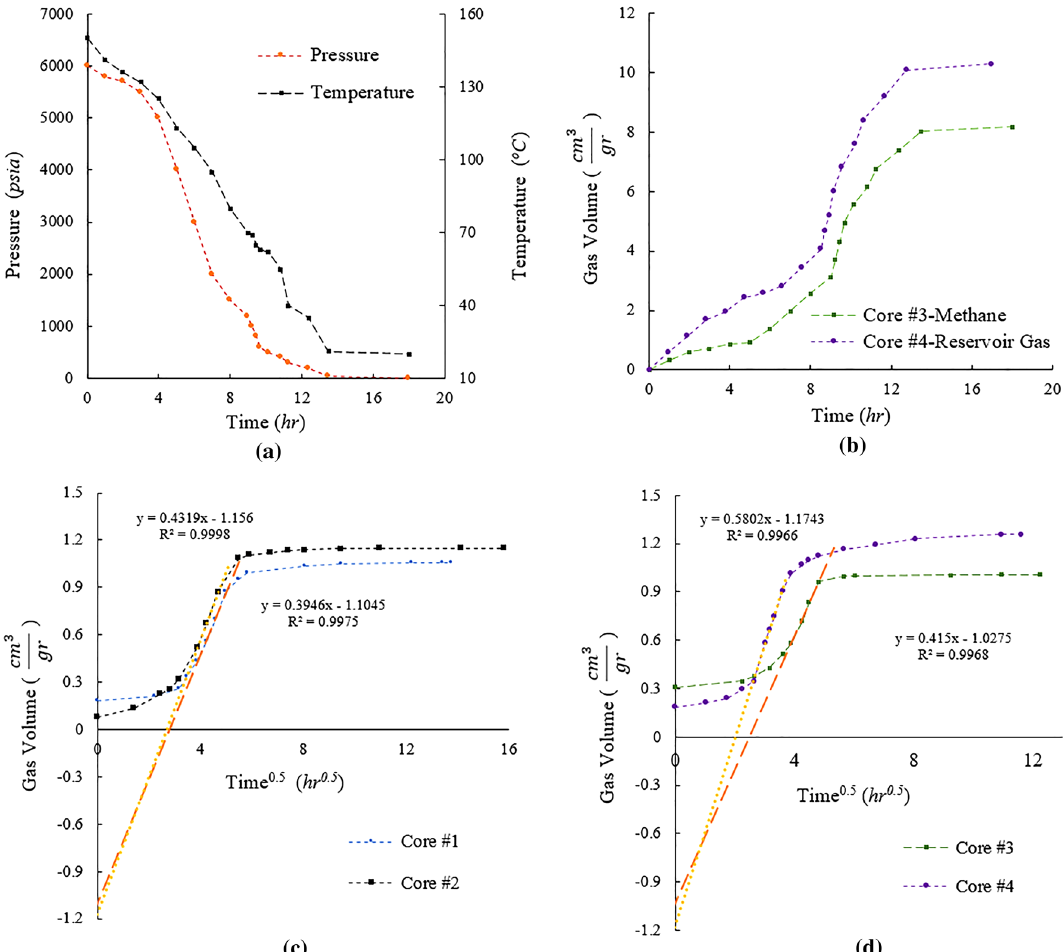
Figure 5. Results of laboratory experiments performed on 4 shale core samples (Cores#1–4). ( c ) The temporal profiles of gas volume from canister tests performed on Core #1 and #2. ( a ) the pressure and temperature drops imposed on the high-pressure cores, i.e. Core #3 and #4, which is relevant to core lifting process. ( b ) The gas volumes collected during decompressing period. ( d ) the canister tests were performed on the charged samples and the temporal gas volume profiles are depicted. For canister test the total gas recovered is in range of 450–500 ml which is 2% of measurement uncertainty. For the pressurized samples, the total gas recovered is 2000–2500 ml, which leads to measurement uncertainty of